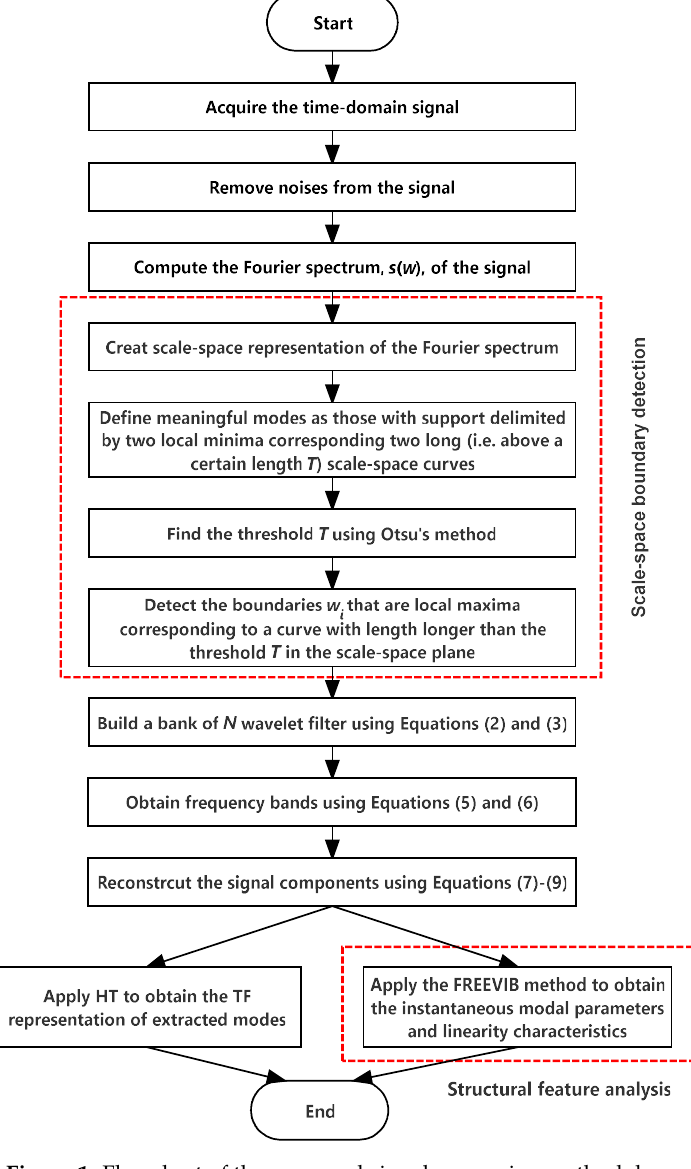
Figure 1. Flowchart of the proposed signal processing methodology.